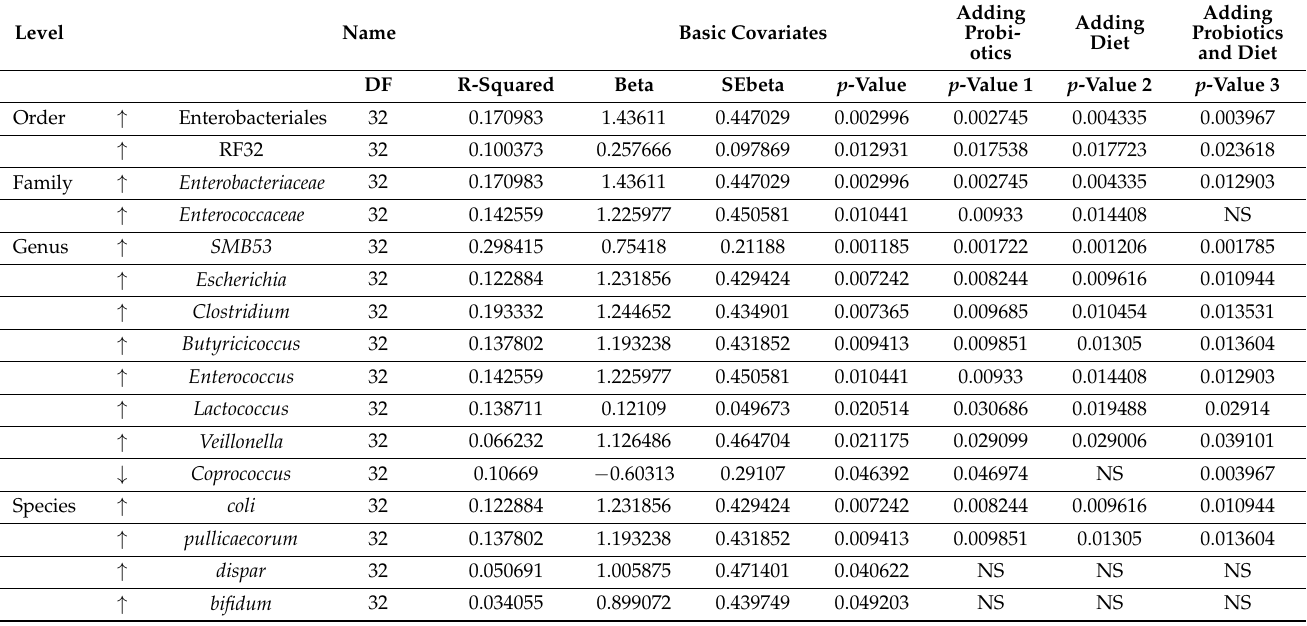
Table 3. Significant absolute abundances of bacterial taxa in NDD compared to